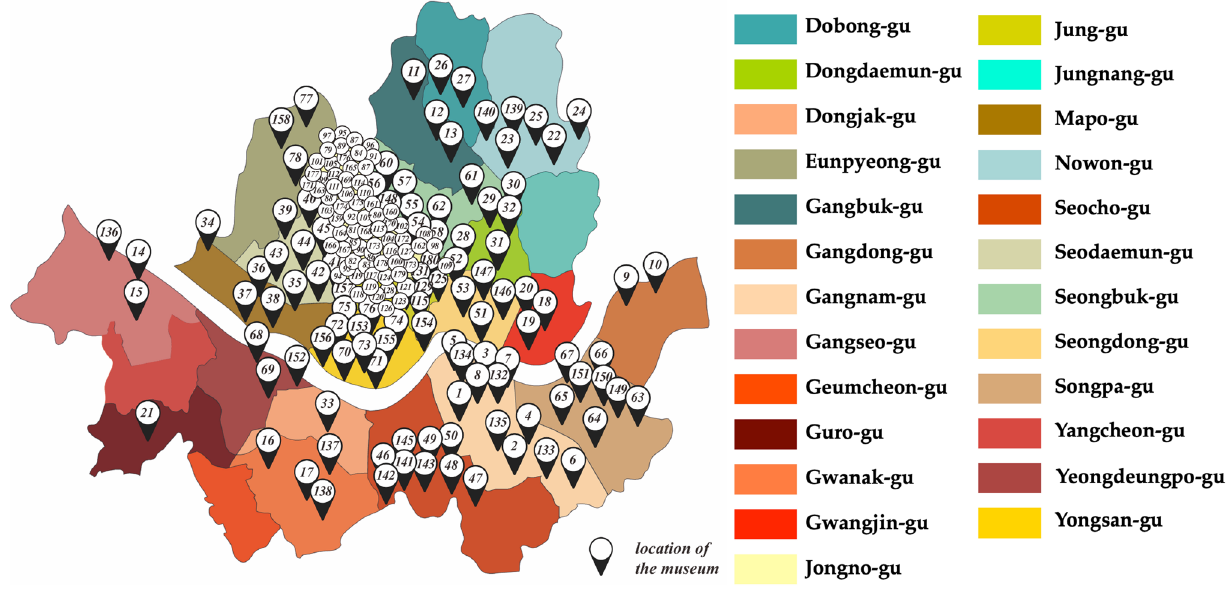
Figure 5. Administrative categories and museum distribution in Seoul. Table 4. Urban hierarchy actuality in